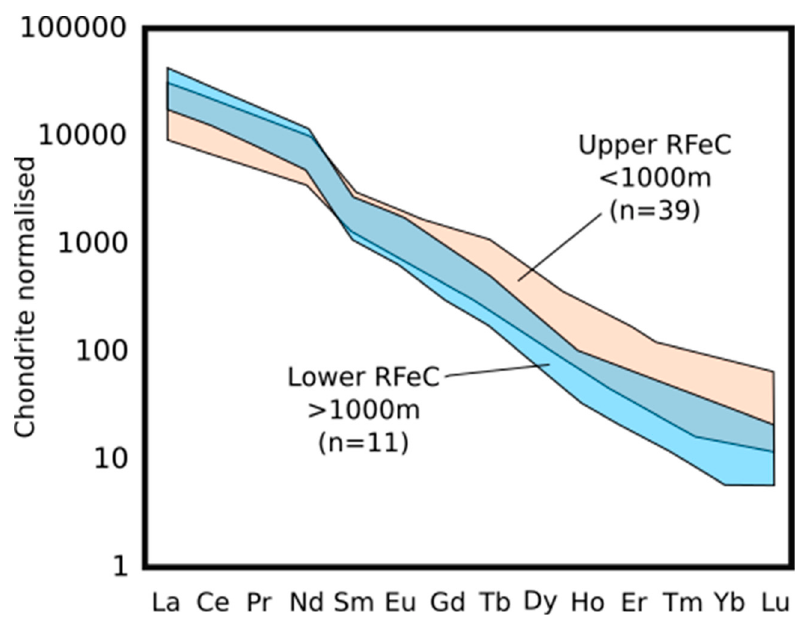
Figure 9. REE patterns (full range) of the upper REE-rich Fe-carbonatite (Upper RFeC–pink) and the lower portion of the REE-rich Fe-carbonatite (Lower RFeC–blue). Chondrite data from McDonough and Sun [61].